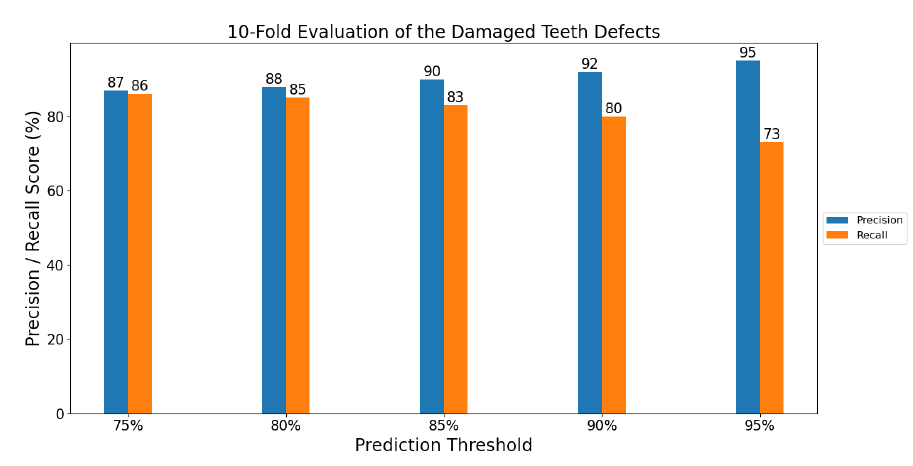
Figure 5. Average precision and recall of the 10-folds for the damaged teeth defects.